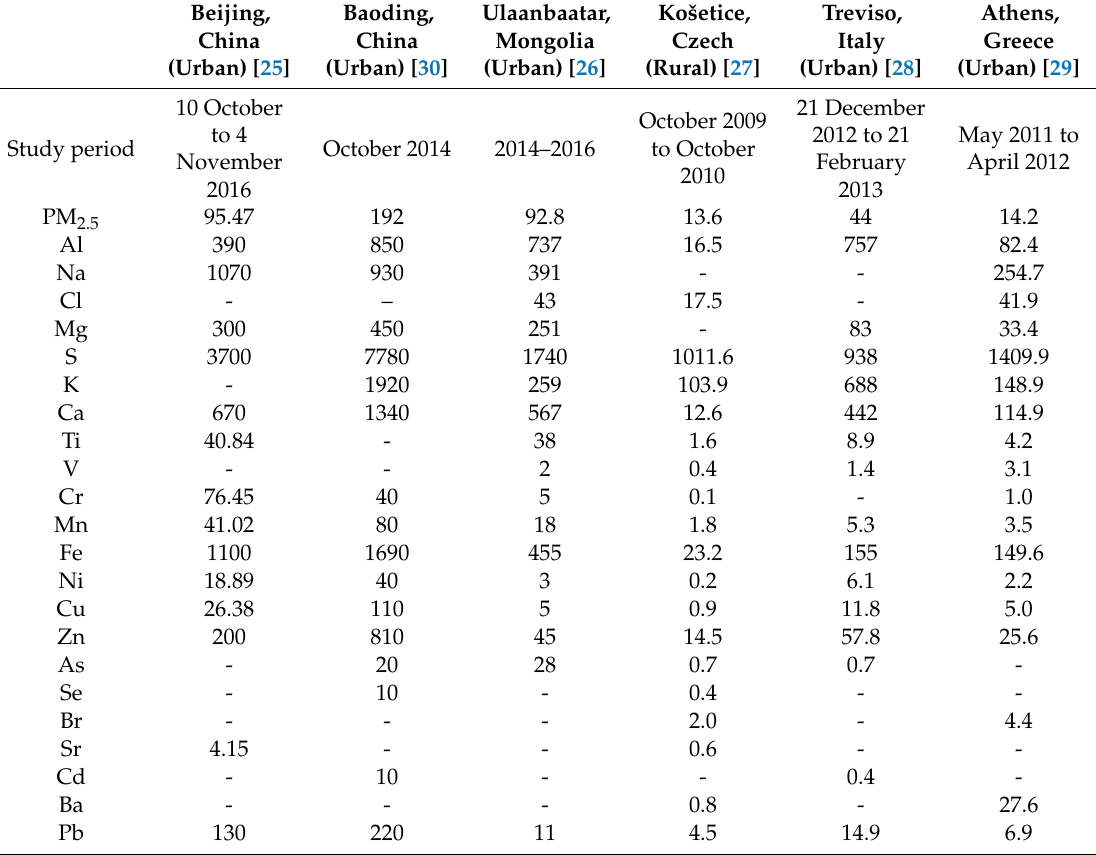
Table 2. Concentrations of PM 2.5 ( µ g m − 3 ) and trace elements (ng m − 3 ) in other